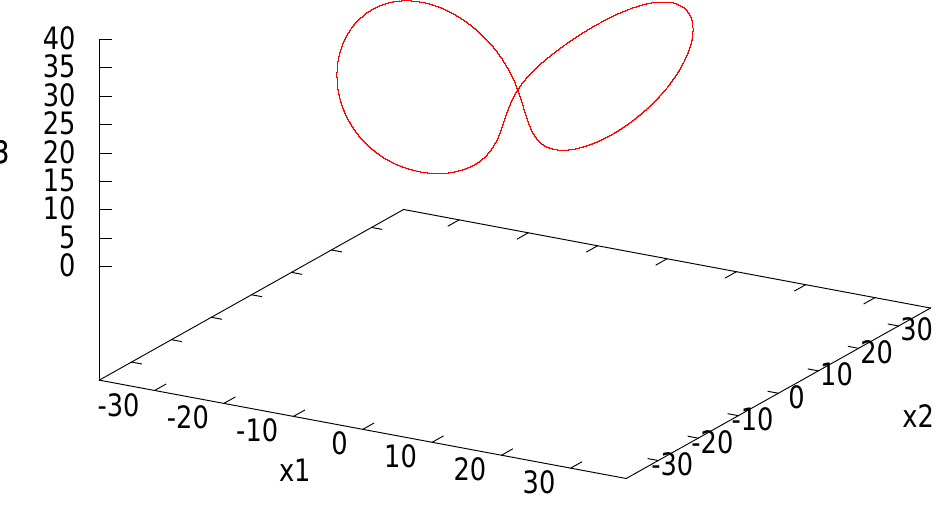
Figure 1. The cycle in the system (2) obtained by the FGBFI